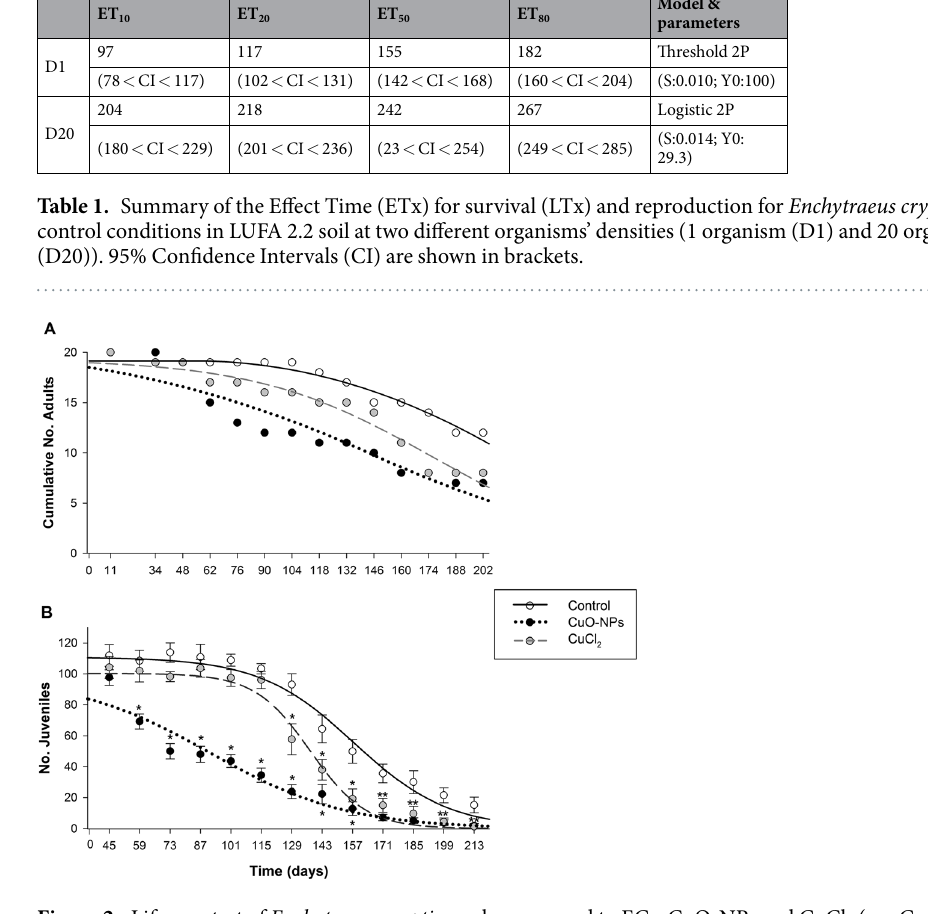
Figure 2. Lifespan test of Enchytraeus crypticus when exposed to EC 50 CuO-NPs and CuCl 2 (mg Cu/kg DW soil) in LUFA 2.2 soil, over-time. ( A ) Adults survival; all values are expressed as cumulative number (N = 20), ( B ) Reproductive output; all values are expressed as average ± standard error (N = 20). Asterisks indicate significant differences between control and treatments at each sampling day (p < 0.05 Tukey Test or Dunn’s method). The lines represent the model fit to